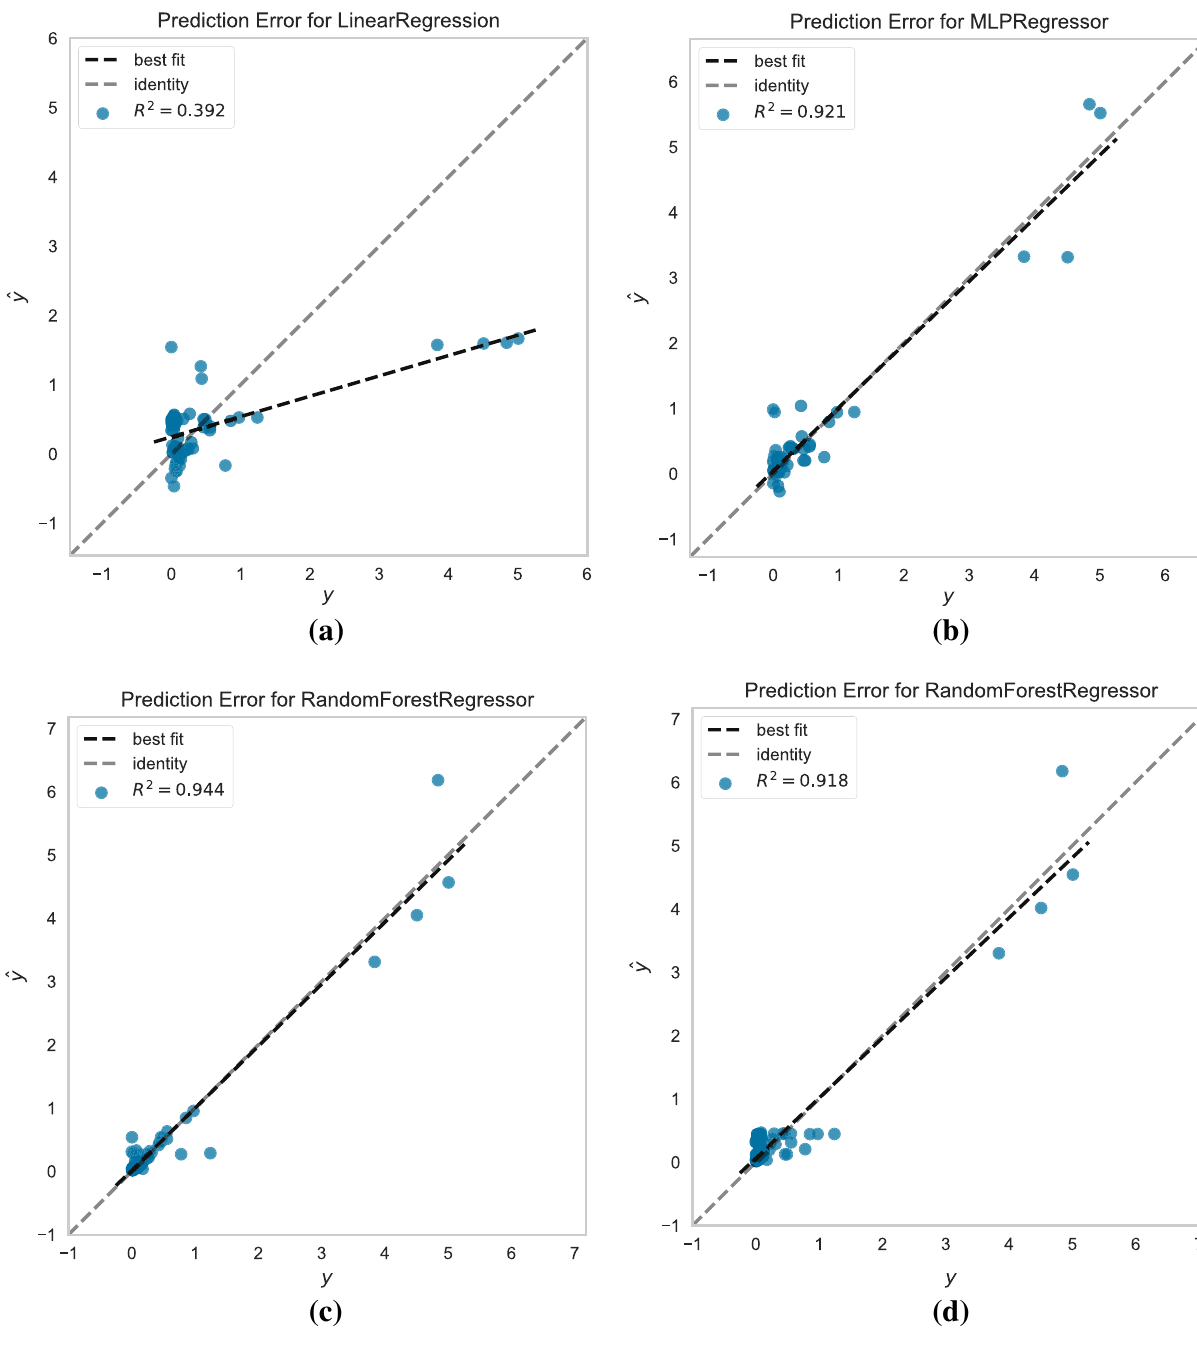
Figure 4. Prediction error plots for the ( a ) MVR, ( b ) MLP, ( c ) RF, and ( d ) RF-reduced, with only h l /h and ε wf /ε ff as inputs. Grey dashed line is the 45° line and black dashed line the fitted line for each